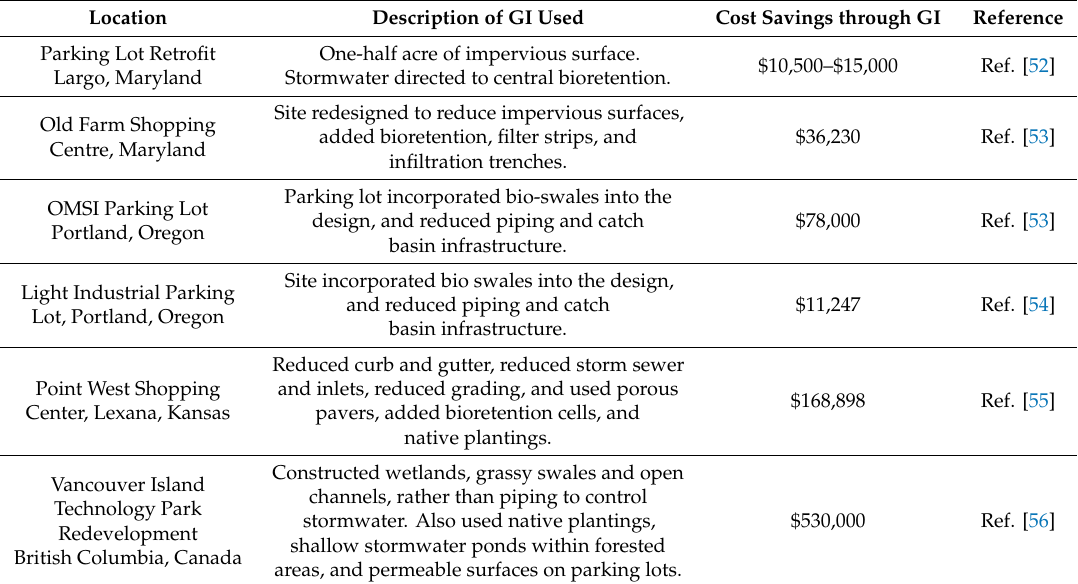
Table 1. Cost Savings through Installing Green Infrastructure (GI) as Stormwater Management Strategies in commercial and Industrial Developments